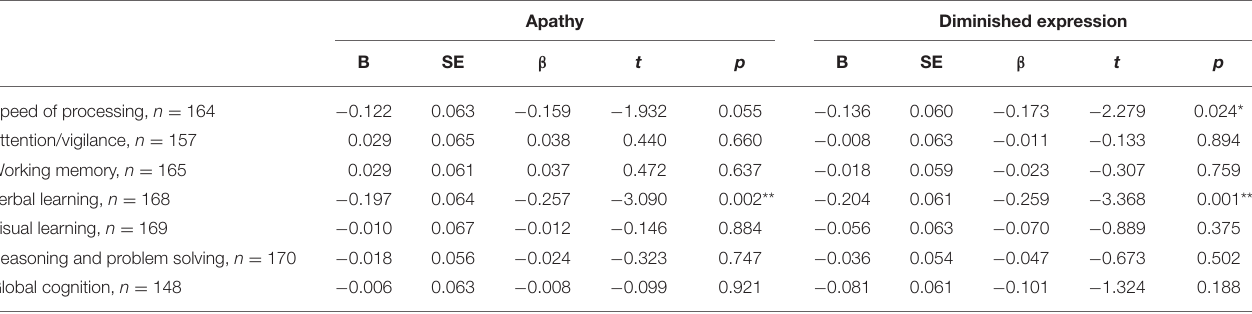
TABLE 5 | Associations between negative symptom domains and